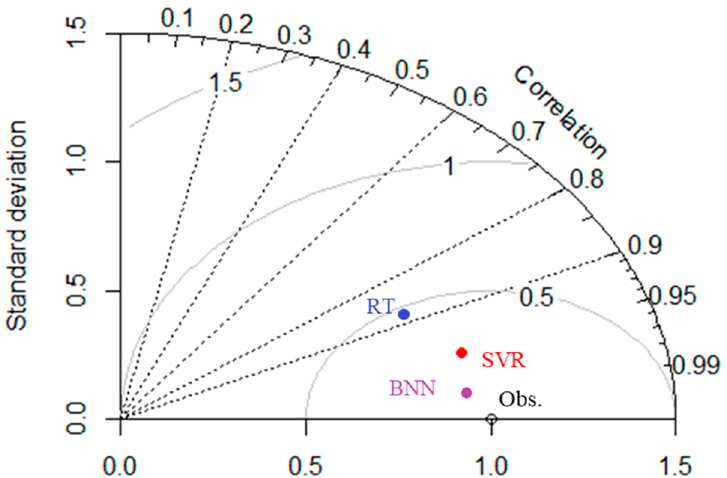
Figure 4. Taylor diagram of the forecasted Bayesian neural network (BNN) (purple dot), support vector regression (SVR) (red dot), and regression tree (RT) (blue dot) against the observed power values (white dot), over the test set evaluation period.